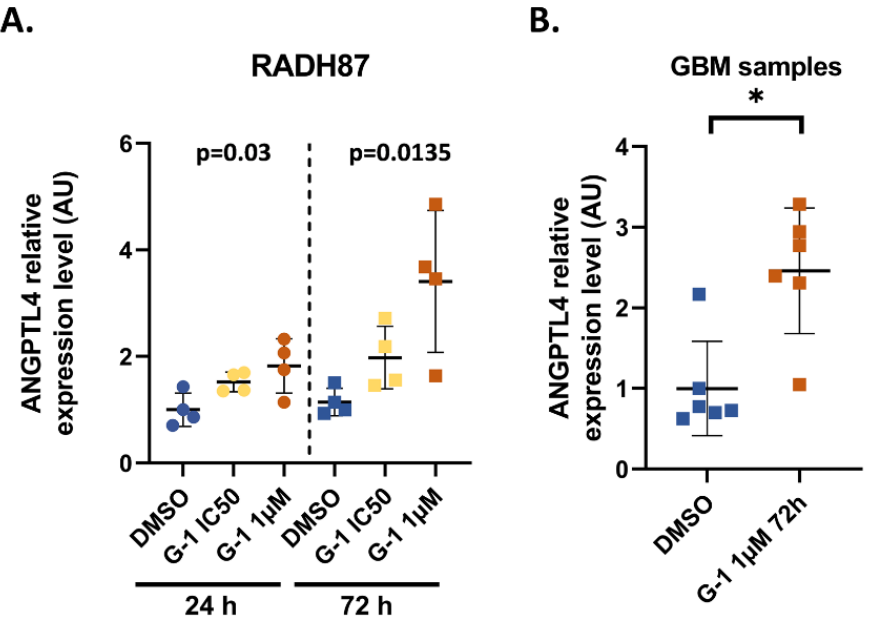
Figure 3. ANGPTL4 is a marker of G-1 exposure. ( A ) Expression level of ANGPTL4 determined by RT-qPCR in RADH87 primary GBM cells after exposure to DMSO 0.01% (vehicle) or G-1 IC50 (562.5 nM)/1 µ M for 24 h and 72 h; n = 4. ( B ) Expression level of ANGPTL4 in 6 GBM patient samples after exposure to vehicle or G-1 1 µ M after 72 h. Data are presented as the mean ± SD. Significance level was determined using ANOVA for RADH87 and by Wilcoxon tests in patient samples, where * indicates p < 0.05.